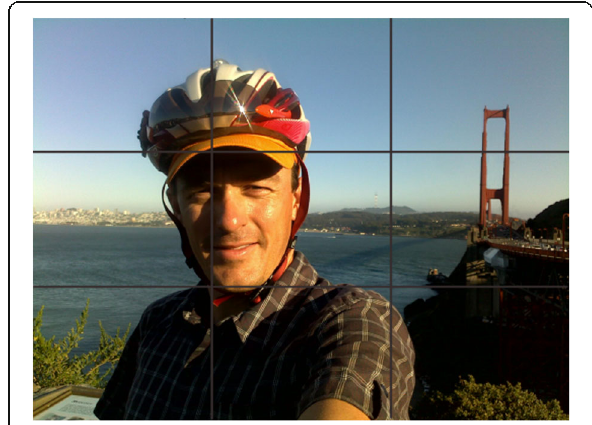
Fig. 2 Example of a photo with the location grid overlaid. Photo credit: Vin Cox, CC BY-SA 3.0 license